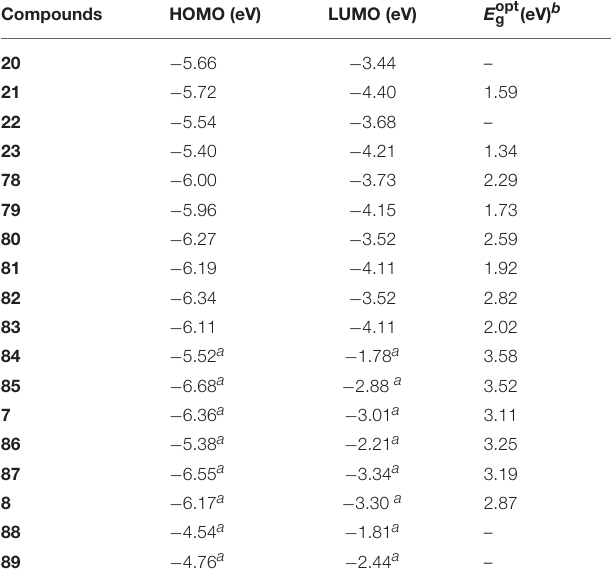
TABLE 1 | Frontier orbital energy levels and optical bandgaps of B ← N embedded π -units. Compounds HOMO (eV)